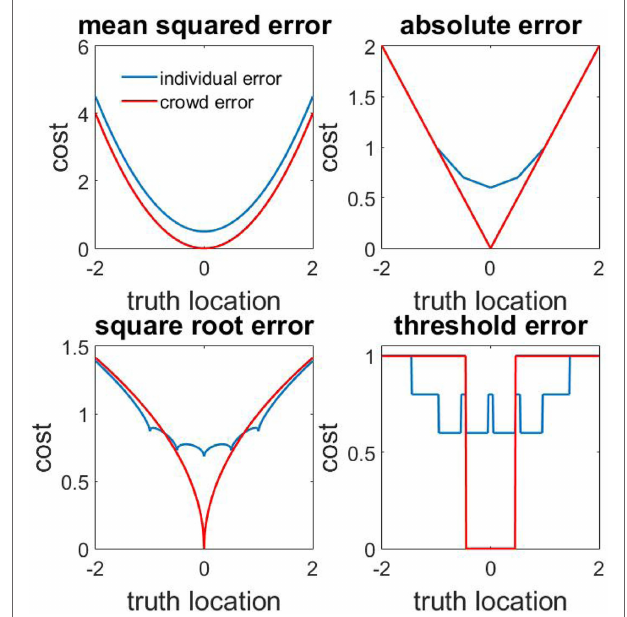
FIGURE 5 | Comparison of averaging and choosing strategies for different cost functions. Cost incurred by the averaging strategy (red curve) and the choosing strategy (blue curve) as a function of the location of the true value for four different cost functions. The five opinion values on which the performance is calculated: (cid:0) 1, (cid:0) 0.5, 0, 0.5, and 1. Quadratic cost is strictly convex, and mean (red) is then always below choosing (blue). Absolute error cost function is weakly convex, and mean (red) is then always below or equal to choosing (blue). Square the third and fourth curves are neither convex nor concave. The threshold cost function gives a cost of 0 if an opinion is closer than 0.45 to the truth and a cost of 1 for all other values. √ errors increase. The crowd mean has a cost of 183 − 180 = 1 .